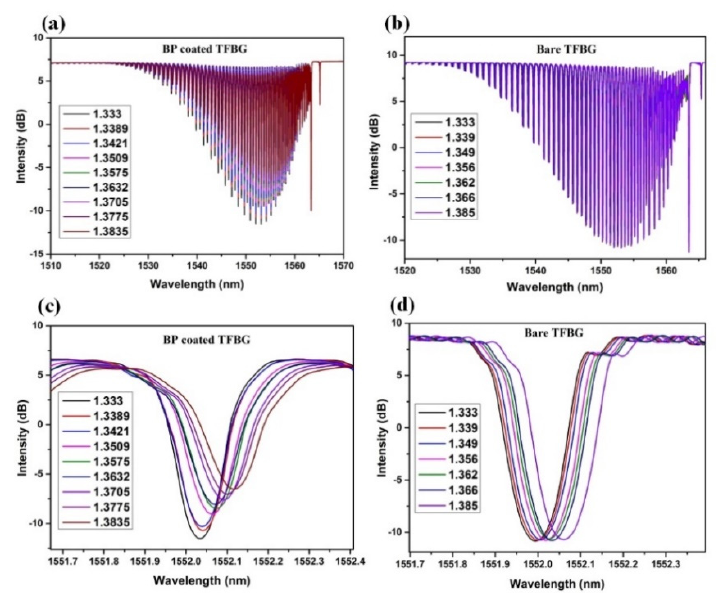
Figure 7. Transmission spectra of whole cladding modes and the cladding mode of around 1552nm for weakly tilted fiber Bragg grating (WTFBG) with ( a , c ), and without ( b , d ) black phosphorus (BP) coating, in the detection of solution with di ff erent refractive indexs (RIs).